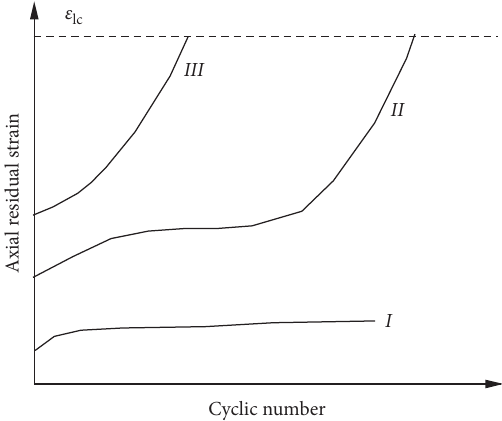
Figure 3: Classification of development curves of axial residual